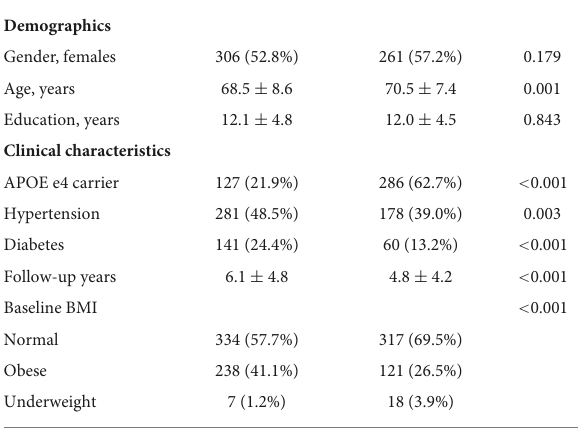
TABLE 1 Demographic and clinical characteristics of study participants.